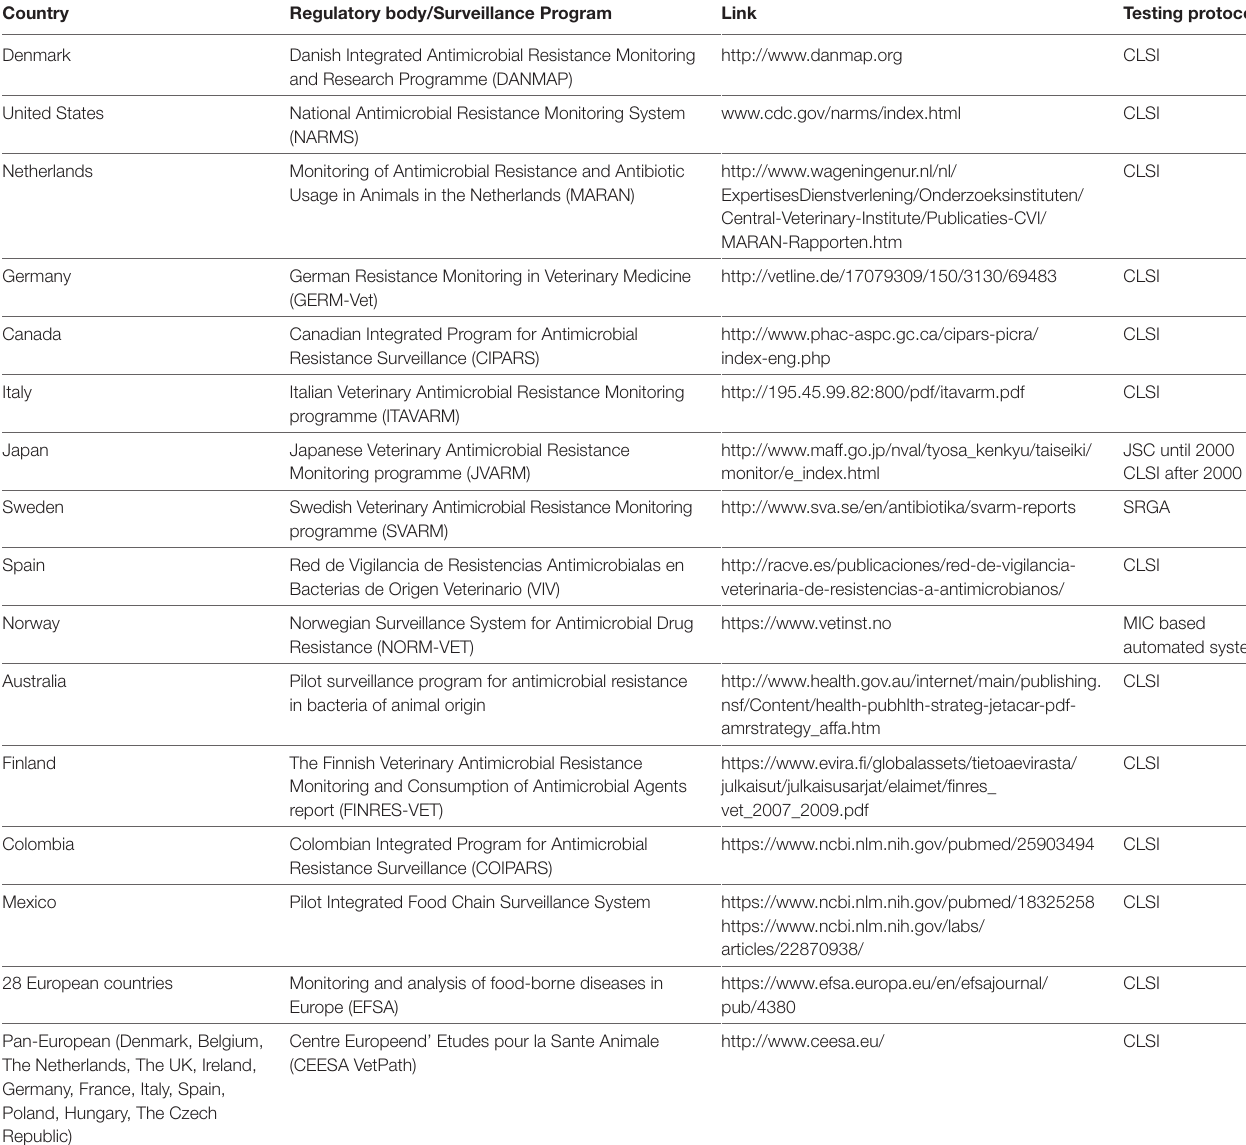
TABLe 1 | Diverse antimicrobial resistance surveillance and monitoring programs (49, 56, 57).